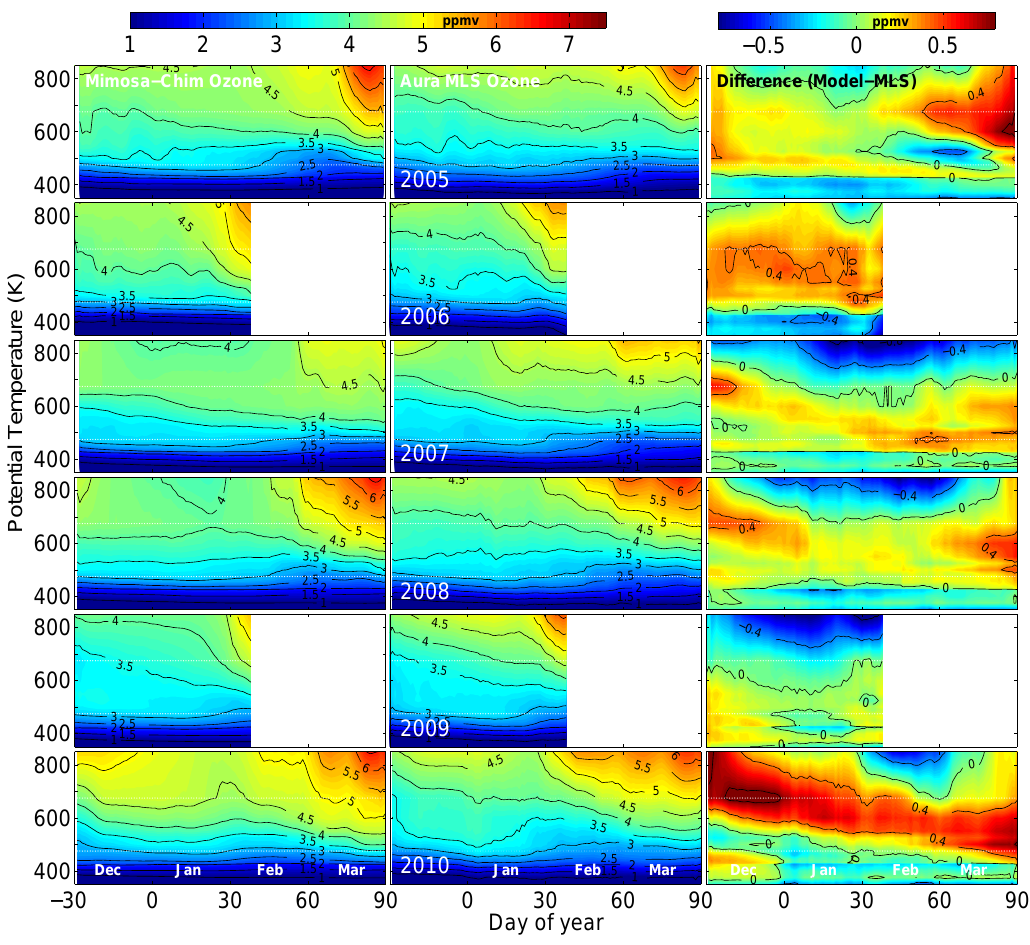
Fig. 2. Temporal evolution of the vertical distribution (350–850K) of vortex averaged ( ≥ 65 ◦ EqL) ozone (ppmv) for the Arctic winters 2005–2010. Left: Mimosa-Chim calculations, Middle: MLS measurements, and Right: The difference between modelled and measured ozone. The model fields are sampled at location of the MLS observations. Due to early vortex dissipation caused by major warmings, the analysis does not extend beyond 10 February in 2006 and 2009. Both data are smoothed for seven days. The white dotted lines represent the study altitudes 475 and